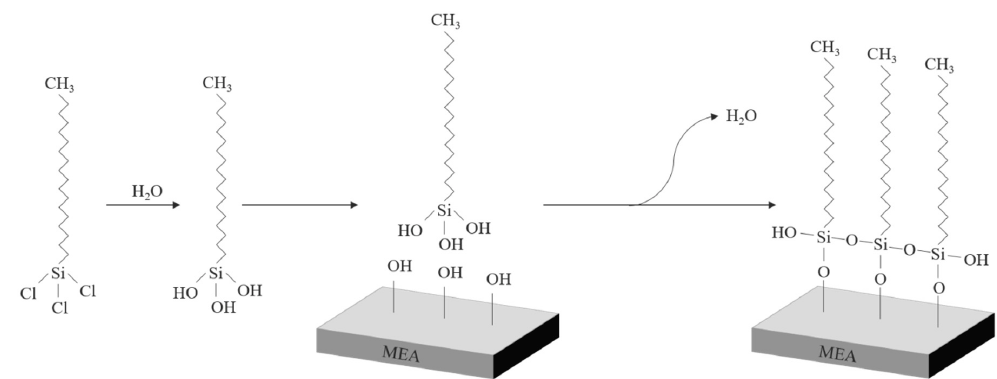
Figure 2. Schematic diagram of octadecyltrichlorosilane (OTS) self-assembly reaction process.